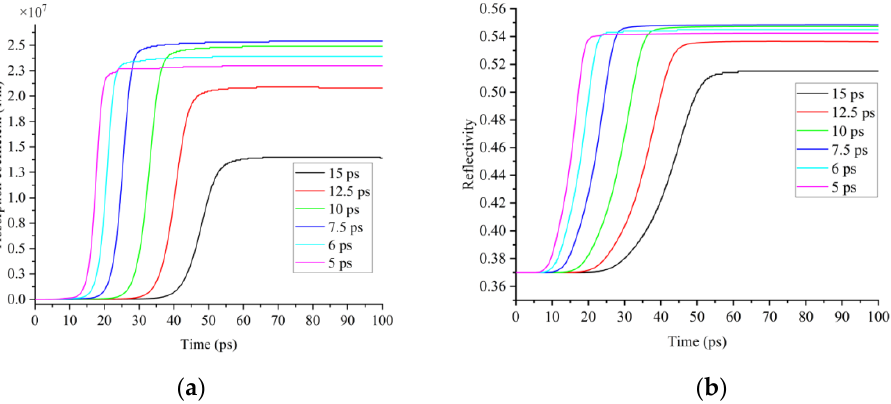
Figure 5. ( a ) Variation characteristic of absorption coefficients; ( b ) variation characteristic of reflection coefficients under the action of picosecond lasers with different pulse widths as 15 ps, 12.5 ps, 10 ps, 7.5 ps, 6 ps and 5 ps.